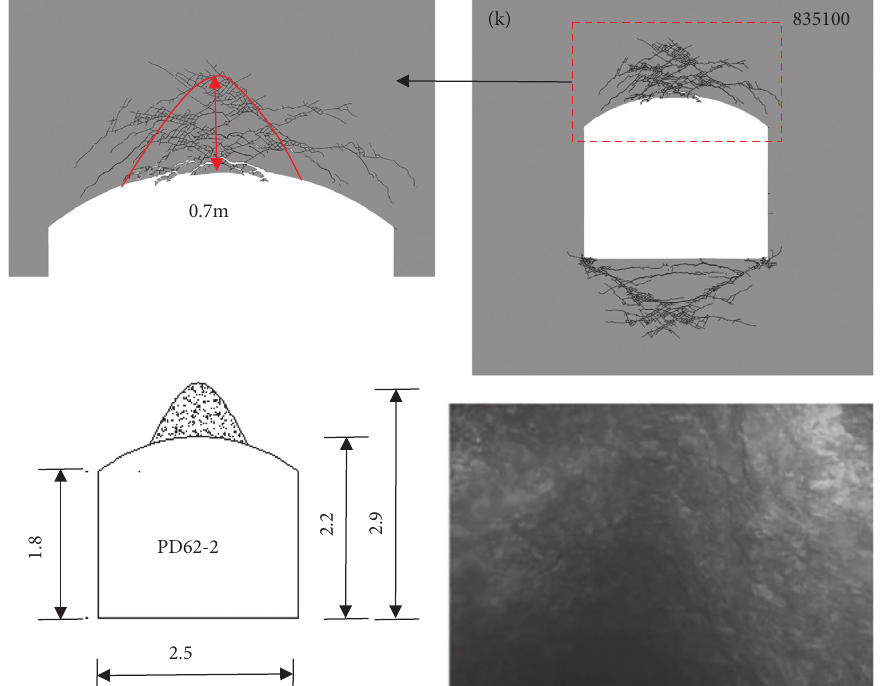
Figure 8: Comparisons of calculated results and field phenomena of spalling failure in